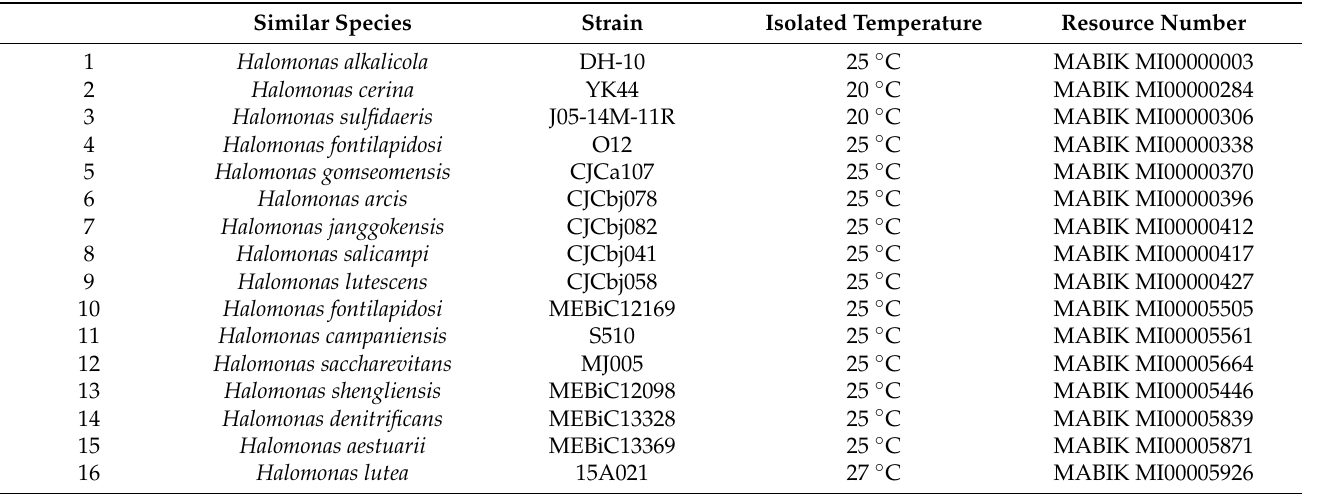
Table 2. Halomonas strains used in this